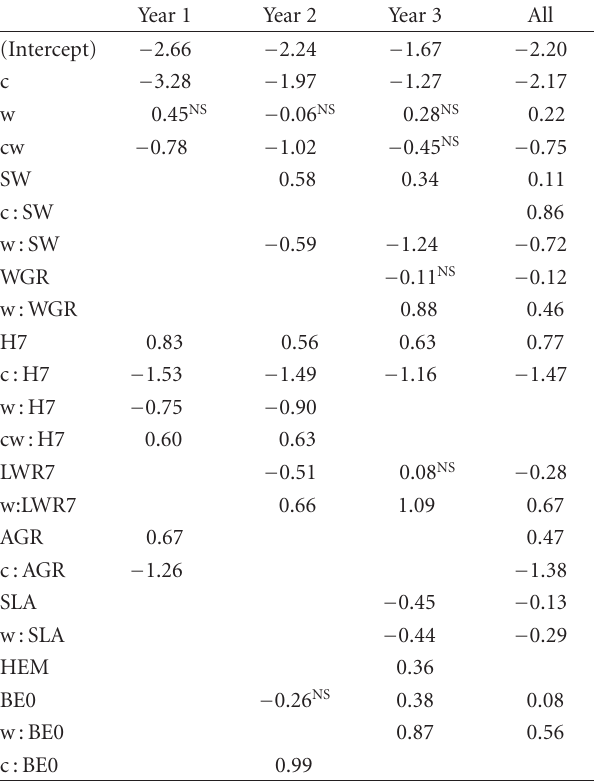
Table 3: Results of the multitrait and multienvironment analysis using tiered forward model selection in mixed models. The fol- lowing treatments c: canopy, w: water logging, and cw: interaction c × w were always in the model as a fixed e ff ect and random e ff ects.